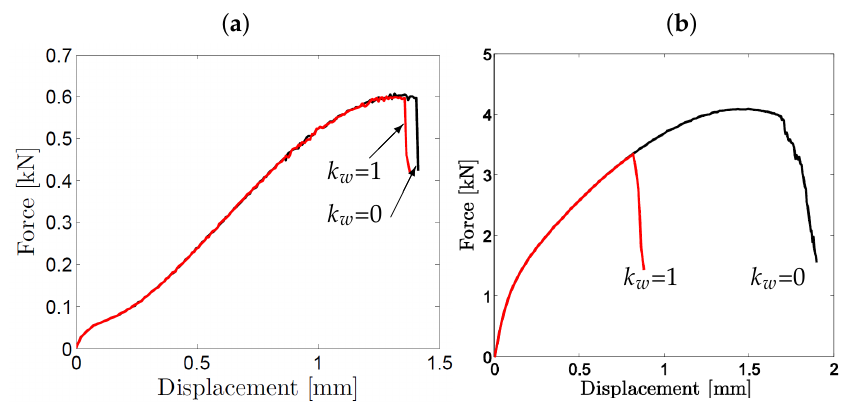
Figure 9. Effect of shear parameter, k w on force-displacement curves: disk thickness of ( a ) 0.2 mm and ( b ) 1 mm for values of k w = 0 and k w = 1.